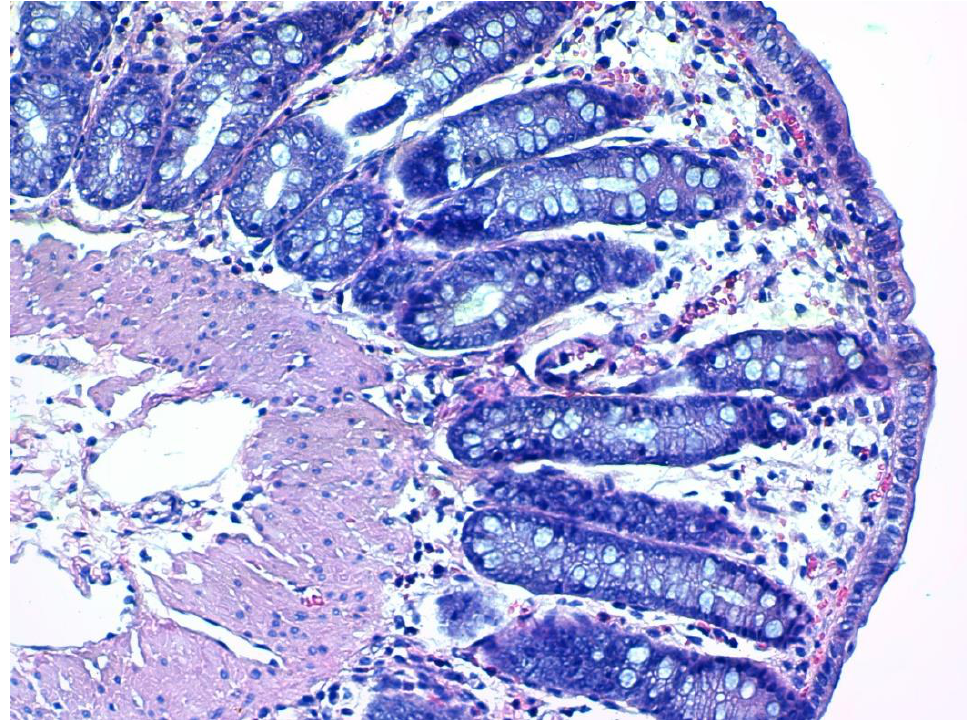
Figure 5. Colon histology of rats in the control group. Control group displayed a normal colonic mucosa, with intact and continuous surface epithelium and closely packed, thin, and long simple tubular colonic glands extending to the muscularis mucosa; small number of inflammatory cells in the mucosa and submucosa. The goblet cells are numerous in the colonic crypts. H&E stain, 20 × . Abbreviations: H&E, hematoxylin and